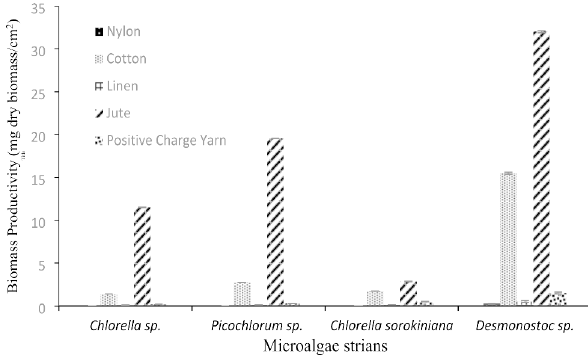
Fig. 3 Comparison biomass productivity (mg dry biomass cm -2 ) between different microalgae strains on various supporting materials (nylon, cot- ton, linen, jute and positive charge yarn) (Value presented as mean ±